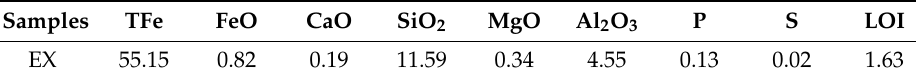
Table 3. Chemical composition of the iron ores (mass